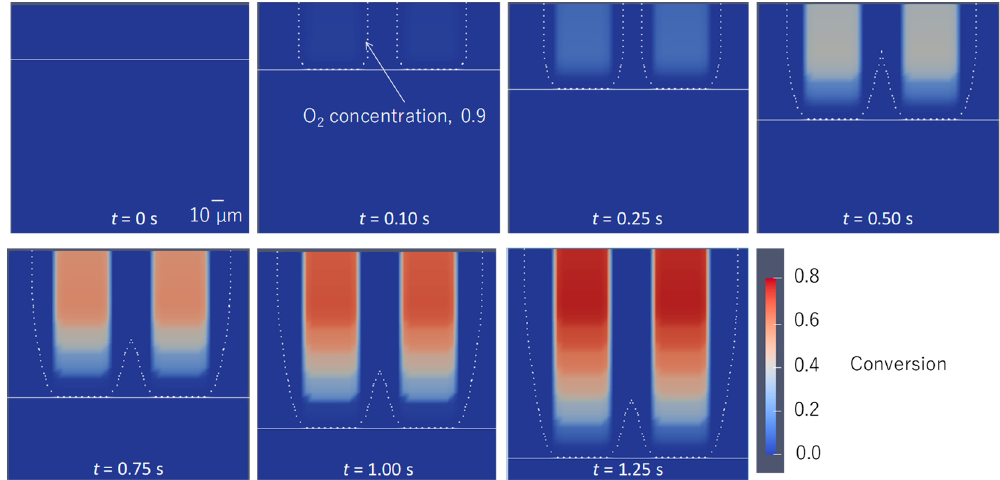
Figure 2. Contour plot of normalized oxygen concentration of 0.9 and C=C bond conversion distribution at a lift-up speed of 0.1 mm/s. The corresponding video is Video S1 on the website of the Supplementary Materials.